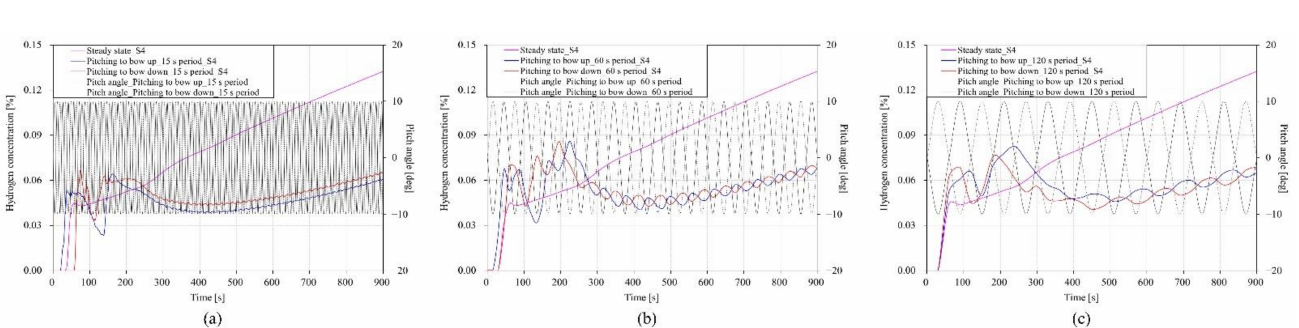
Figure 15. Hydrogen concentration by pitch motion at S4: ( a ) 15 s period; ( b ) 60 s period; ( c ) 120 s